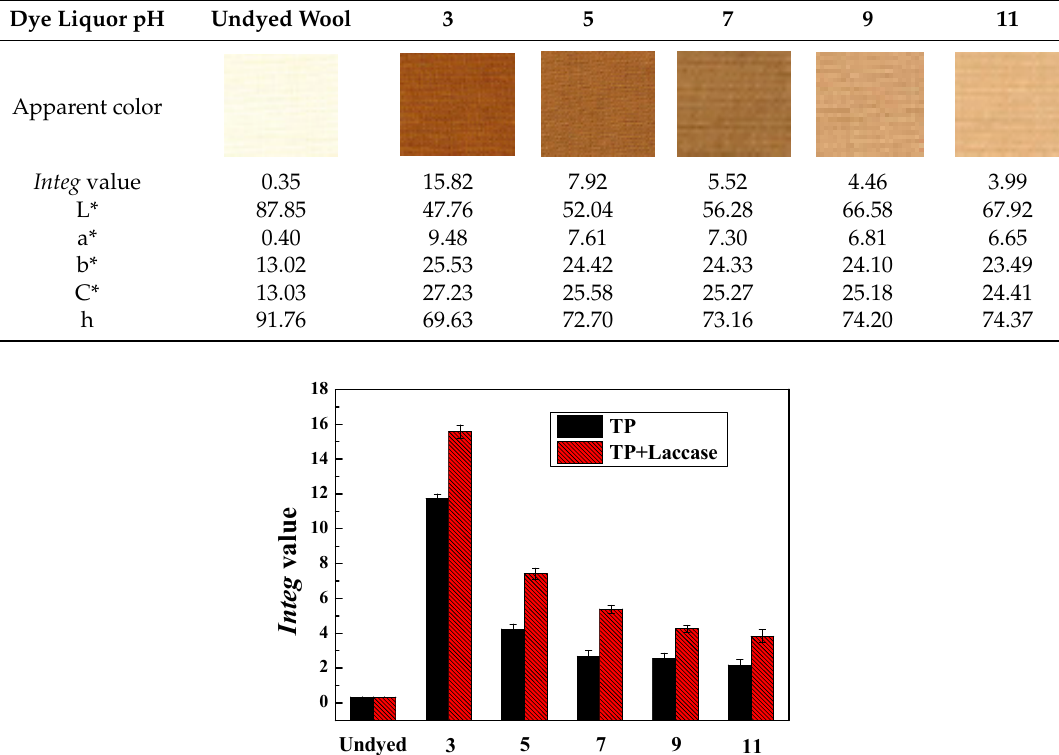
Table 4. The color parameters of dyed wool fabrics based on laccase-catalyzed oxidative polymerization for tea polyphenols.